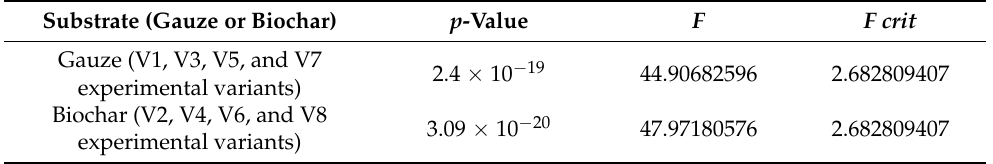
Table 2. A one-way ANOVA test for radicle lengths of Lepidium sativum L. sprouts. Substrate (Gauze or Biochar)